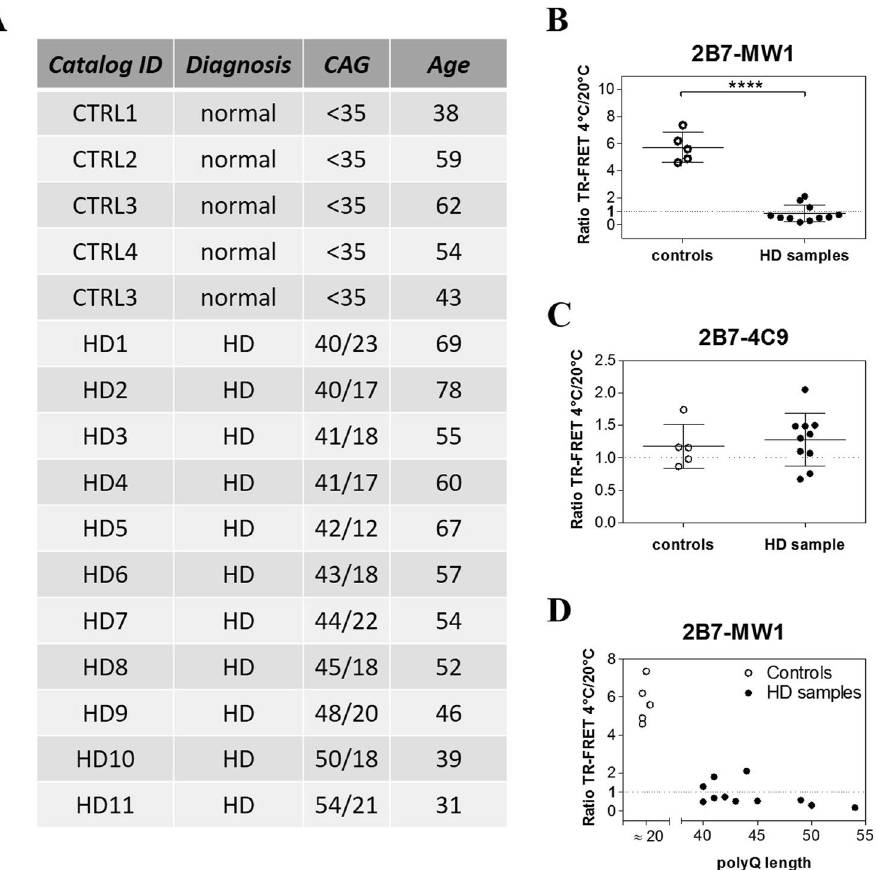
Figure 7. The 2B7/MW1 conformational immunoassay detects mHTT conformation in lysates of control and HD human PBMCs. ( A ) Table illustrating the salient features of human control and HD donors of samples for this study. ( B ) Summary of 2B7/MW1 conformational immunoassay data (ratio TR-FRET signals at 4 °C/20 °C) obtained on lysates of control and HD PBMCs. ( C ) Summary of 2B7/4C9 control immunoassay data (ratio TR- FRET signals at 4 °C/20 °C) obtained on the same lysates of control and HD fibroblasts. ( D ) Same as A, plotted against CAG (polyQ) repeat length rather than against control/HD genotype. In B and C values represent means and standard deviations of the means of three independent experiments (Datasets were tested for normality and Student’s t-test, degrees of significance are